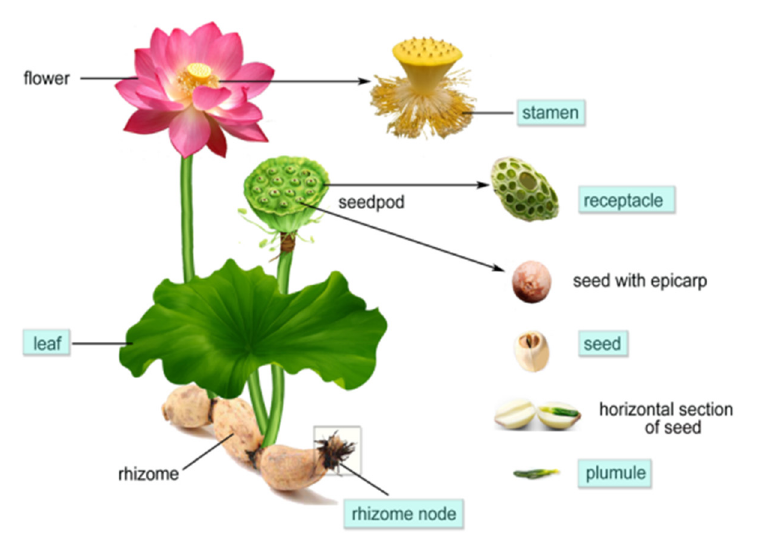
Figure 1. Schematic diagram of the whole lotus plant. The part listed in CP has a blue highlight in the background.